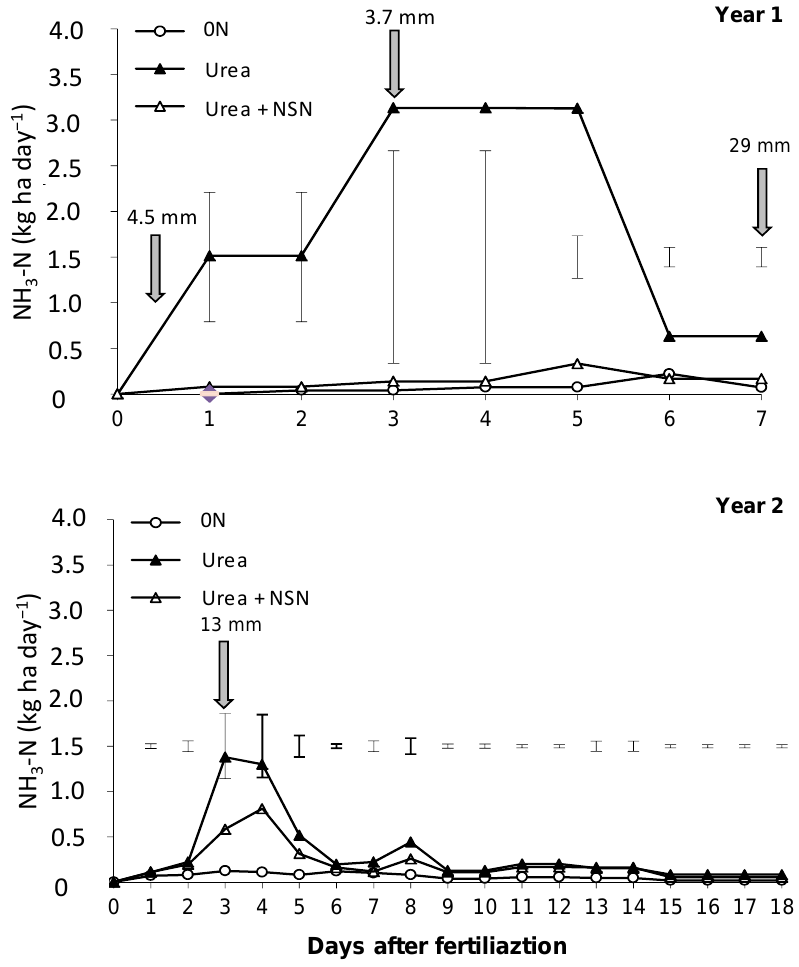
Figure 2. Rates of ammonia N volatilization losses (NH 3 -N, kg ha day − 1 ) from urea or urea treated with NSN (urea + NSN) applied broadcast on the surface to no-till corn during two years. Arrows indicate rainfall dates and amount. Vertical bars indicate LSD test (0.05) values. NSN, maleic itaconic acids.